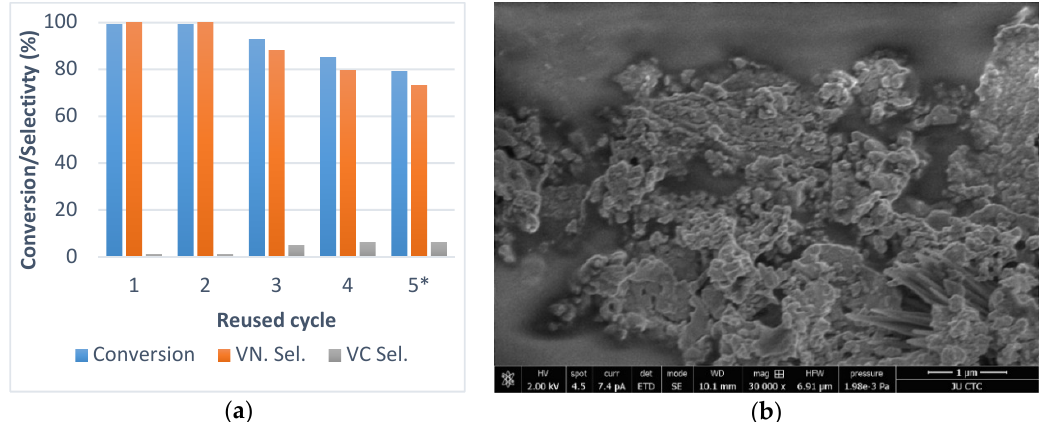
Figure 11. ( a ) Recyclability test of the ZnFe 2 O 4 -NP catalyst where VN is vanillin and VC is vanillic acid and ( b ) SEM image of the ZnFe 2 O 4 -NP catalyst after the 5 th cycle.